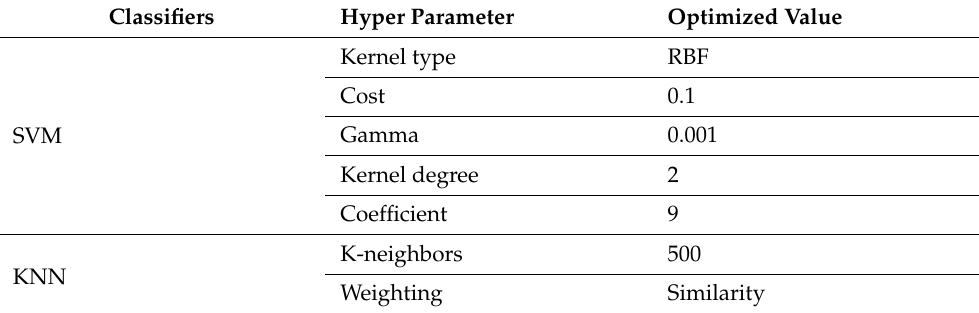
Table 5. Training parameters for SVM and